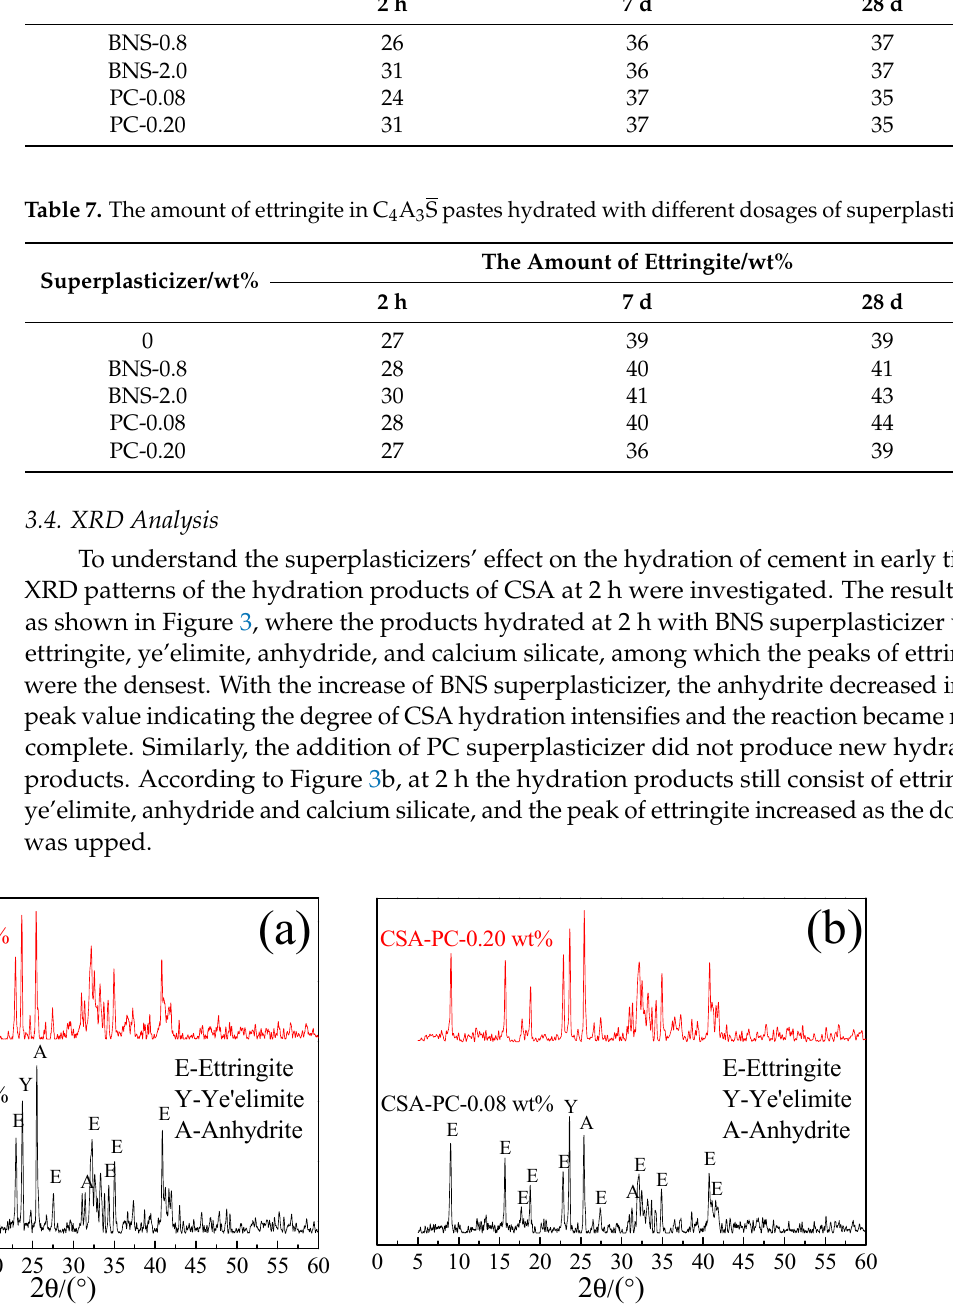
Figure 3. XRD patterns of CSA pastes at 2 h with maximum and minimum dosage superplasticizers of ( a ) BNS, ( b ) PC. Moreover, C 4 A 3 S(cid:3364) hydrated with BNS and PC superplasticizers were tested by XRD at 10 min, 2 h, 1 d, and 7 d after mixing, the results are displayed in Figure 4. It can be seen from it that at the age of 10 min, no matter what the dosages of BNS and PC were, gypsum, C 4 A 3 S(cid:3364) , calcite did not give good hydration. The peak of ettringite appeared from 2 h, and